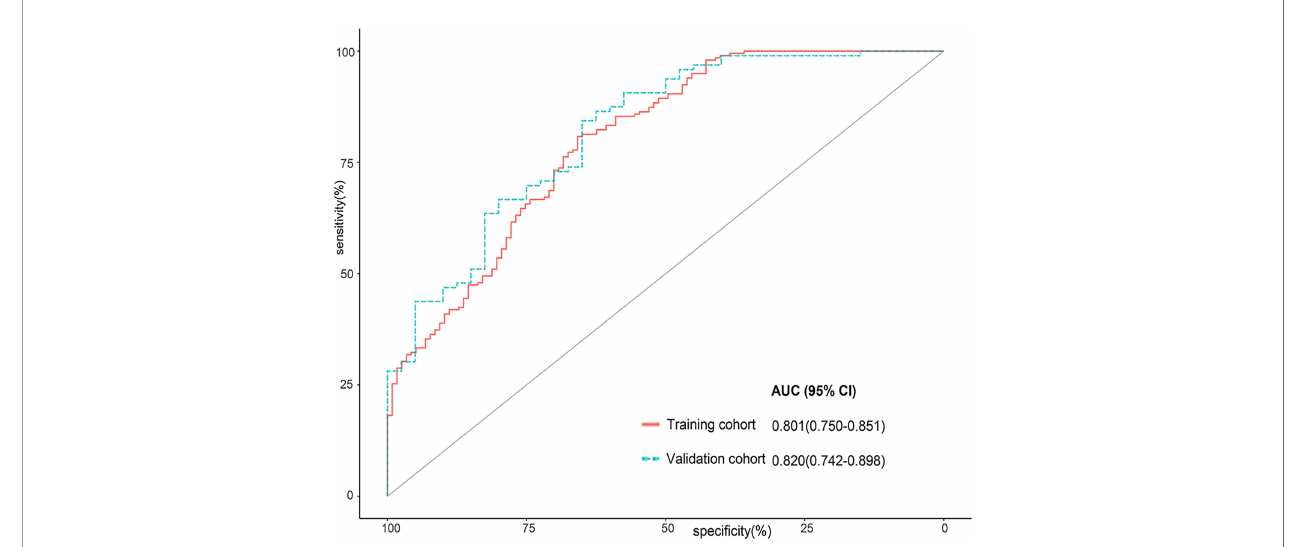
FIGURE 2 | Receiver operator characteristic (ROC) curves for the Rad-Score in the training cohort and the validation cohort.